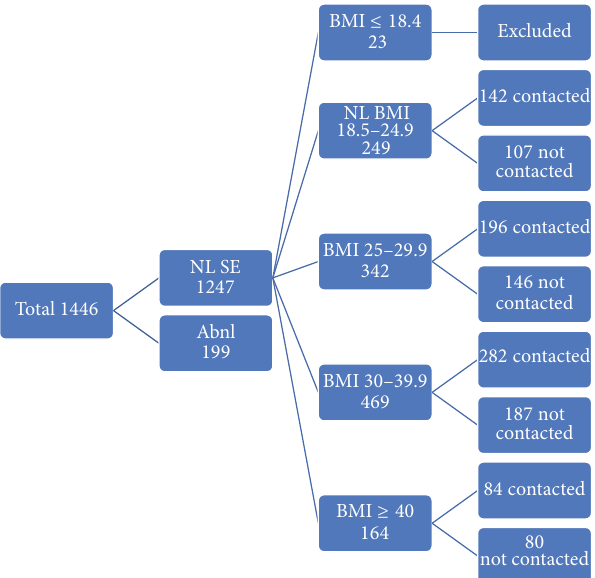
Figure 1: BMI = body mass index, kg/m 2 ; NL = normal; Abnl = abnormal. Data are expressed as a number.